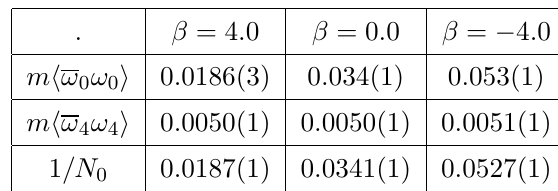
Table 2 . Dependence of condensates on measure coupling (cid:12) for S 4 using N 4 = 200 and bare mass m = 0 :